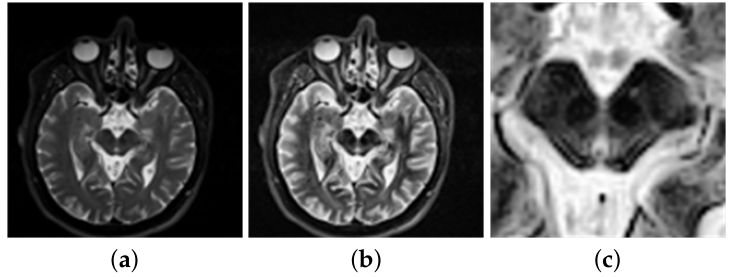
Figure 3. ( a ) Before image enhancement. ( b ) After image enhancement. ( c ) Region of